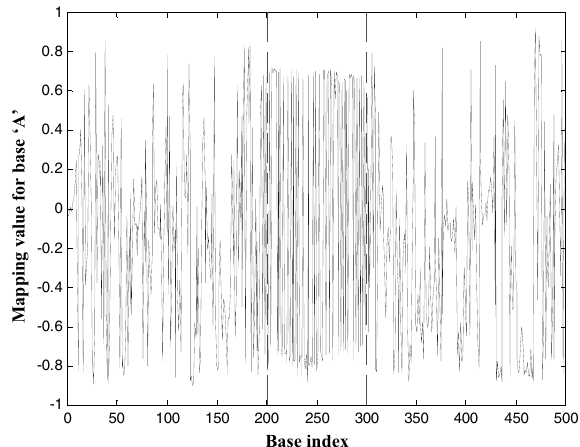
Figure 7 Mapping value for the repetitive base ‘A’ at the frequency of 0.25Hz.